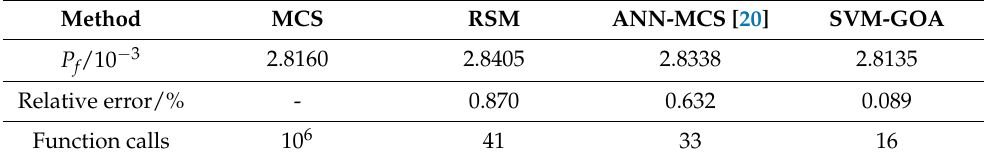
Table 8. Comparison of calculation results of Case 3.